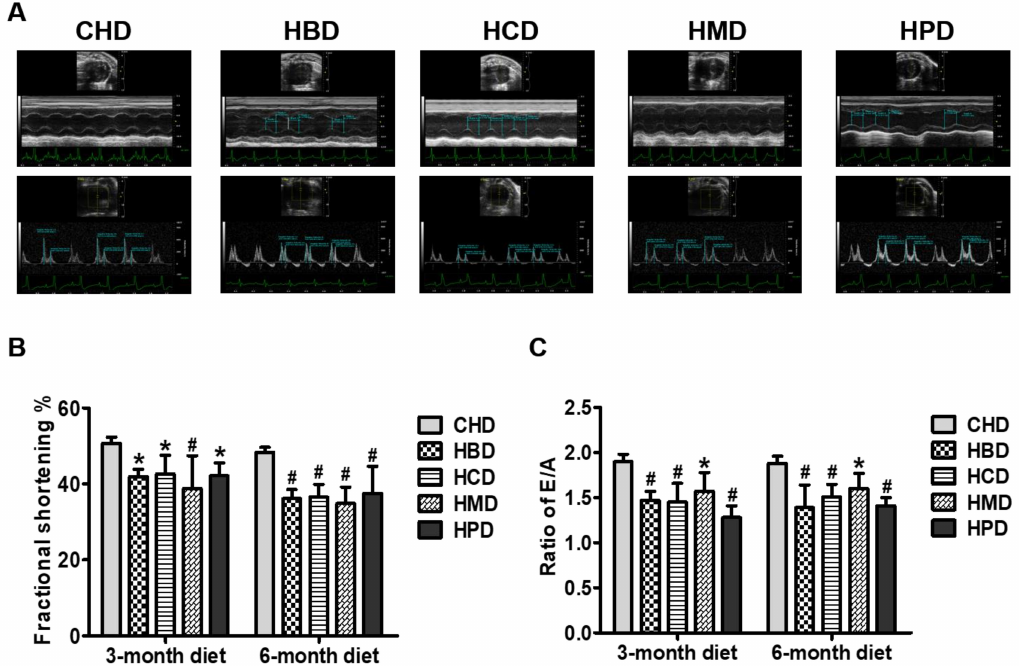
Figure 4. Cardiac function in mice fed high-fat diets. ( A ) Representative echocardiographic images obtained from mice fed 6-month high-fat diets; ( B ) Quantification results of fractional shortening, based on echocardiograms performed at three and six months into the feeding period; ( C ) Quantification results of the ratio of the peak velocity of early to late filling of mitral inflow (E/A), at the indicated time points. Data are presented as mean ± standard deviation, n = 4–7. * p < 0.05 and # p < 0.01 versus